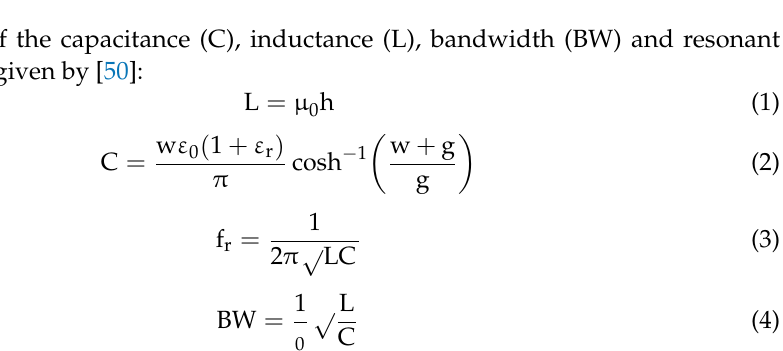
Figure 6. EBG unit-cell: ( a ) vias EBG parameters, and ( b ) Lumped Element Equivalent Circuit of the EBG, adapted from